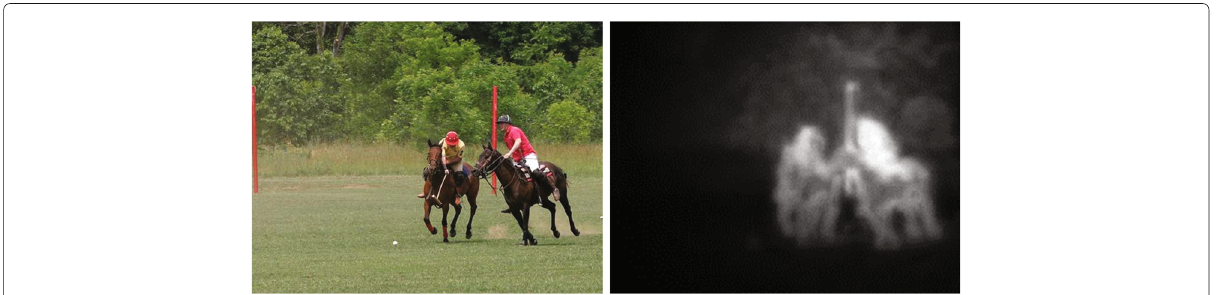
Fig. 3 Saliency map. The brighter the region is, the higher object probability it has